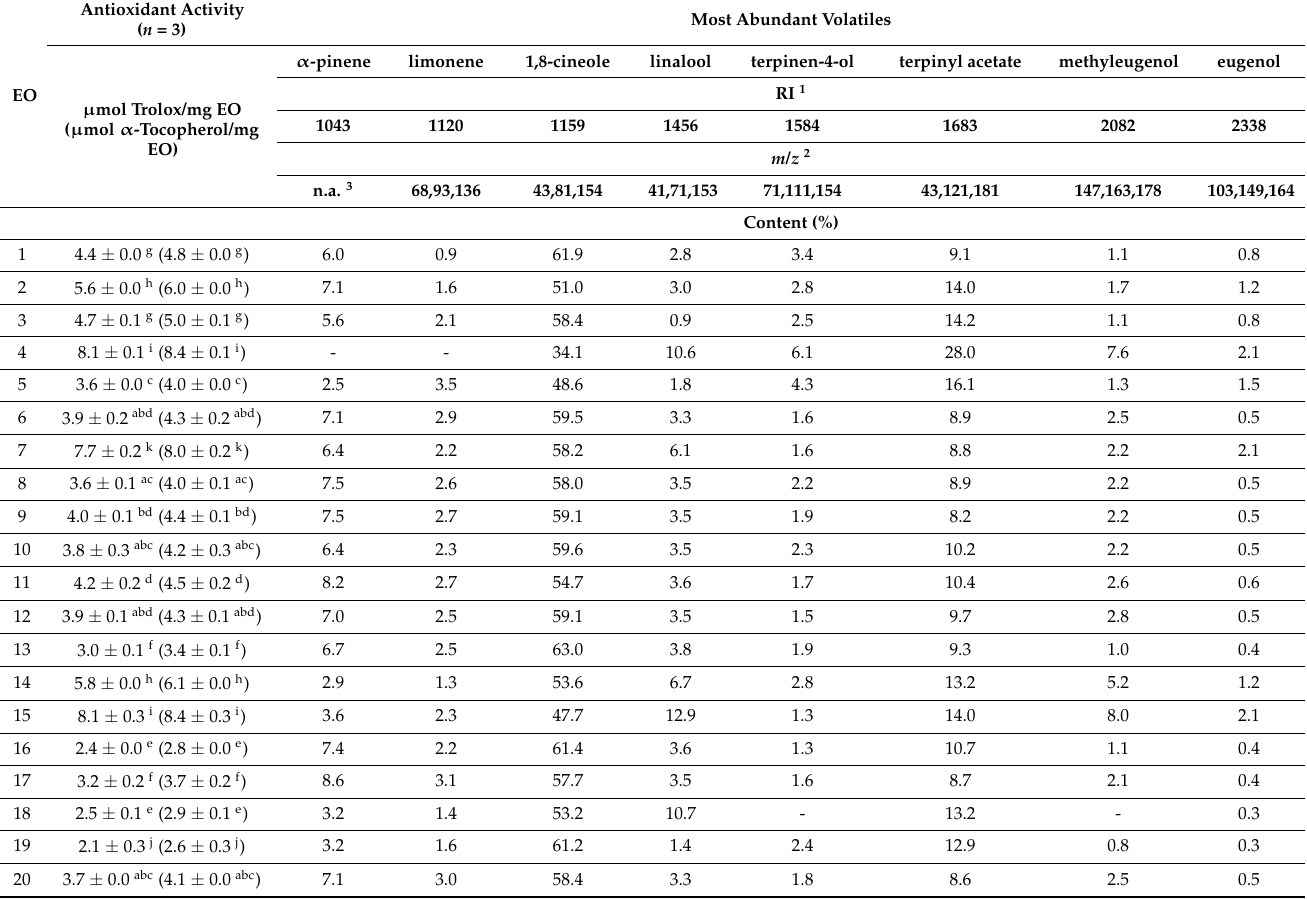
Table 7. Antioxidant activity of bay laurel essential oils (EOs) expressed as Trolox (or α -Tocopherol) equivalents and GC-FID-based percent content of their most abundant components 1 (abstracted from Table 5 in